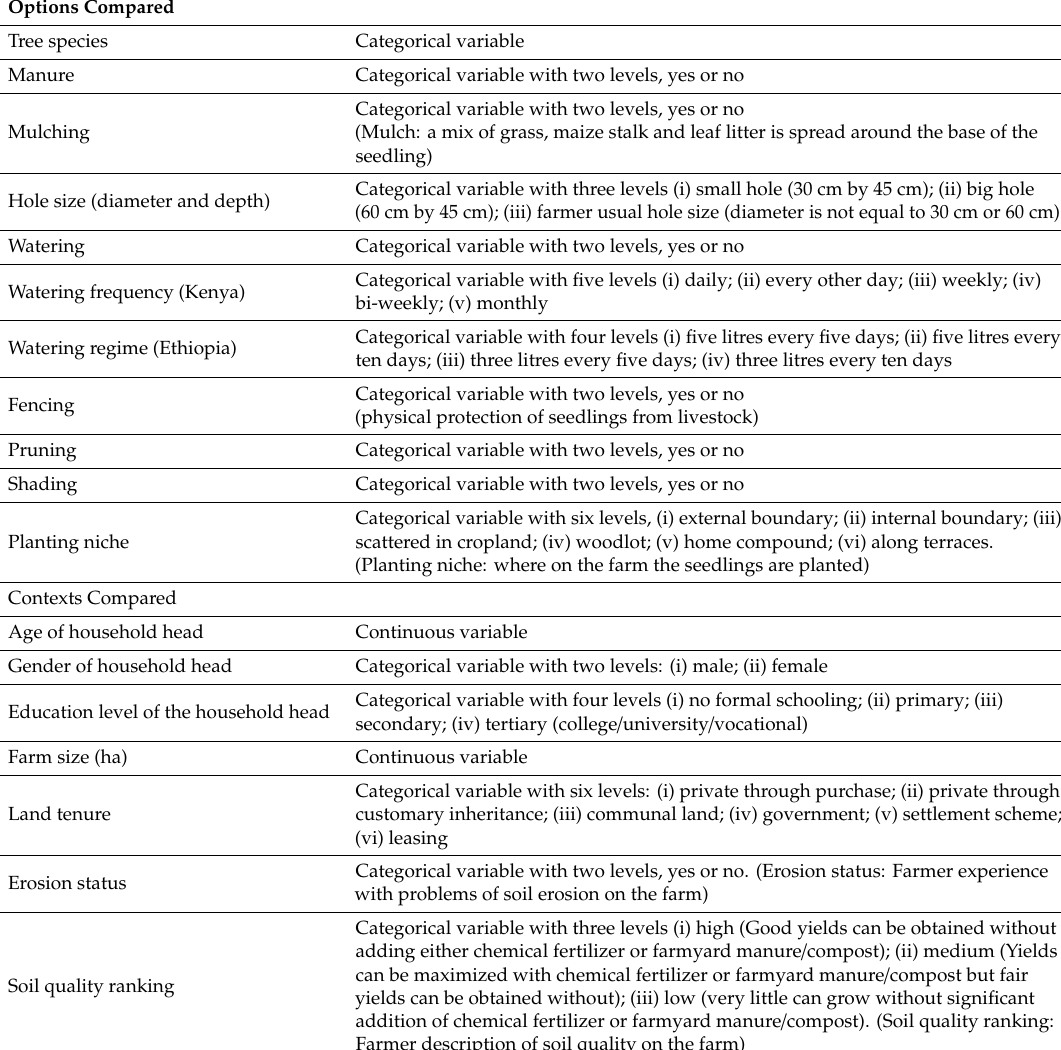
Table 1. Options and contexts compared in the tree planting on-farm planned